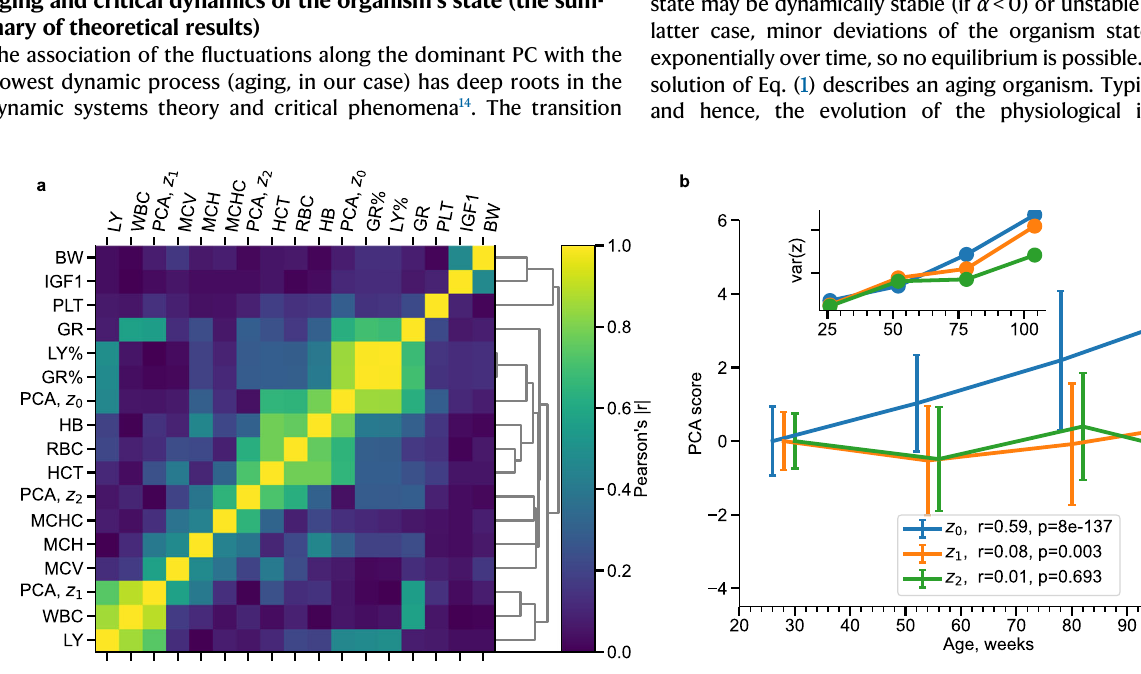
on the right. b The graphs represent the average of the PC scores in subsequent age groups(theerrorbarsarestandarddeviations).Theinsetshowsthatthevariancefor all PC scores increases with age. Two-sided p values were calculated for the Pearson correlation coef fi cient in the sample size of n =1448